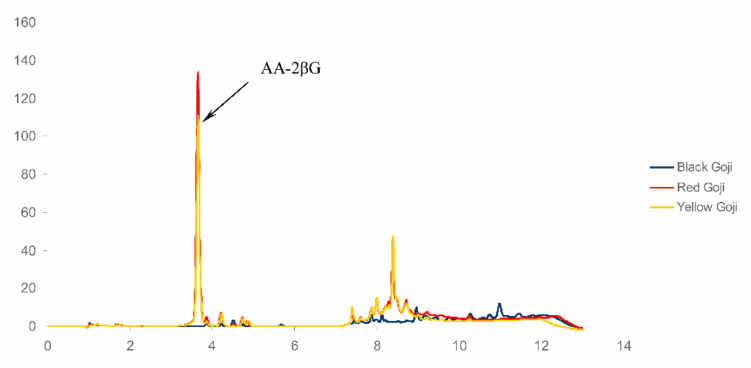
Figure 1. High-performance liquid chromatography (HPLC) chromatogram of goji berry samples at 245 nm. AA-2 β G: 2- O - β - d -glucopyranosyl- l -ascorbic